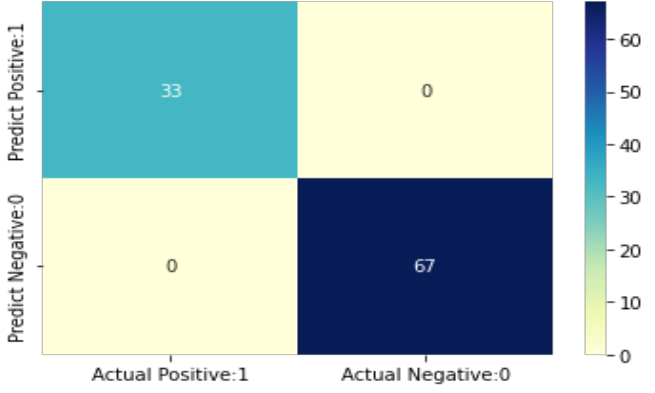
Figure 8. Confusion matrices of the Proposed model.